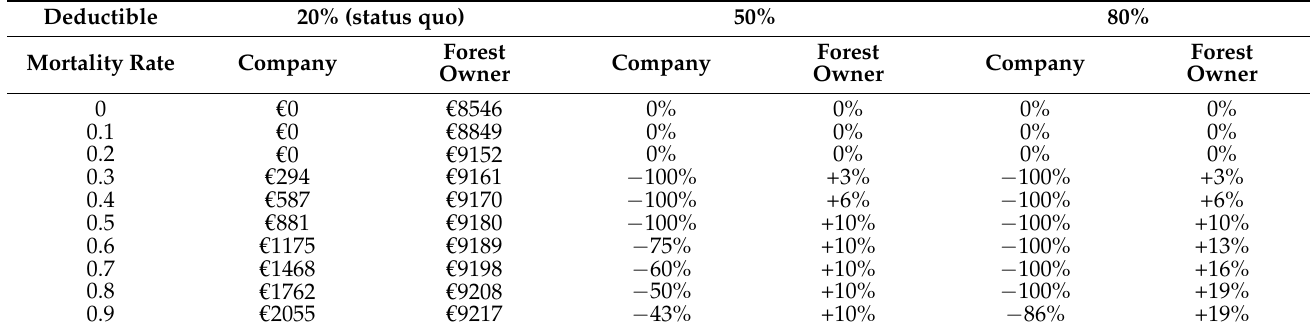
Table 8. Total discounted costs in EUR/ha for sessile oak ( Quercus petraea Liebl.) (itinerary “SO_CS- IP+F”) for the forestry company and the forest owner for a deductible of 20% (current practice), 50%, and 80%. The costs are expressed (for different mortality rates) as variations in percentage of the total discounted costs with respect to the current practice (i.e., status